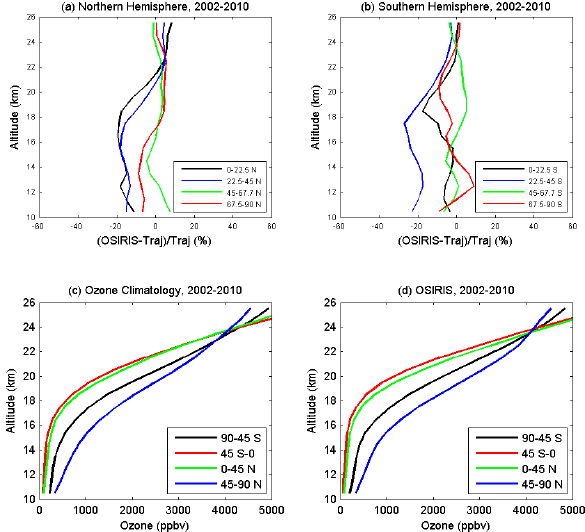
Fig. 9 . Relative difference between the trajectory-derived ozone climatology and OSIRIS data in four latitude zones (a) in the Northern Hemisphere and (b) in the Southern Hemisphere. (c) Global mean ozone profiles from the ozone climatology in four latitude zones: 90–45 ◦ S, 45 ◦ S–0 ◦ , 0–45 ◦ N, and 45–90 ◦ N. (d) Global mean ozone profiles from OSIRIS in the four zones.